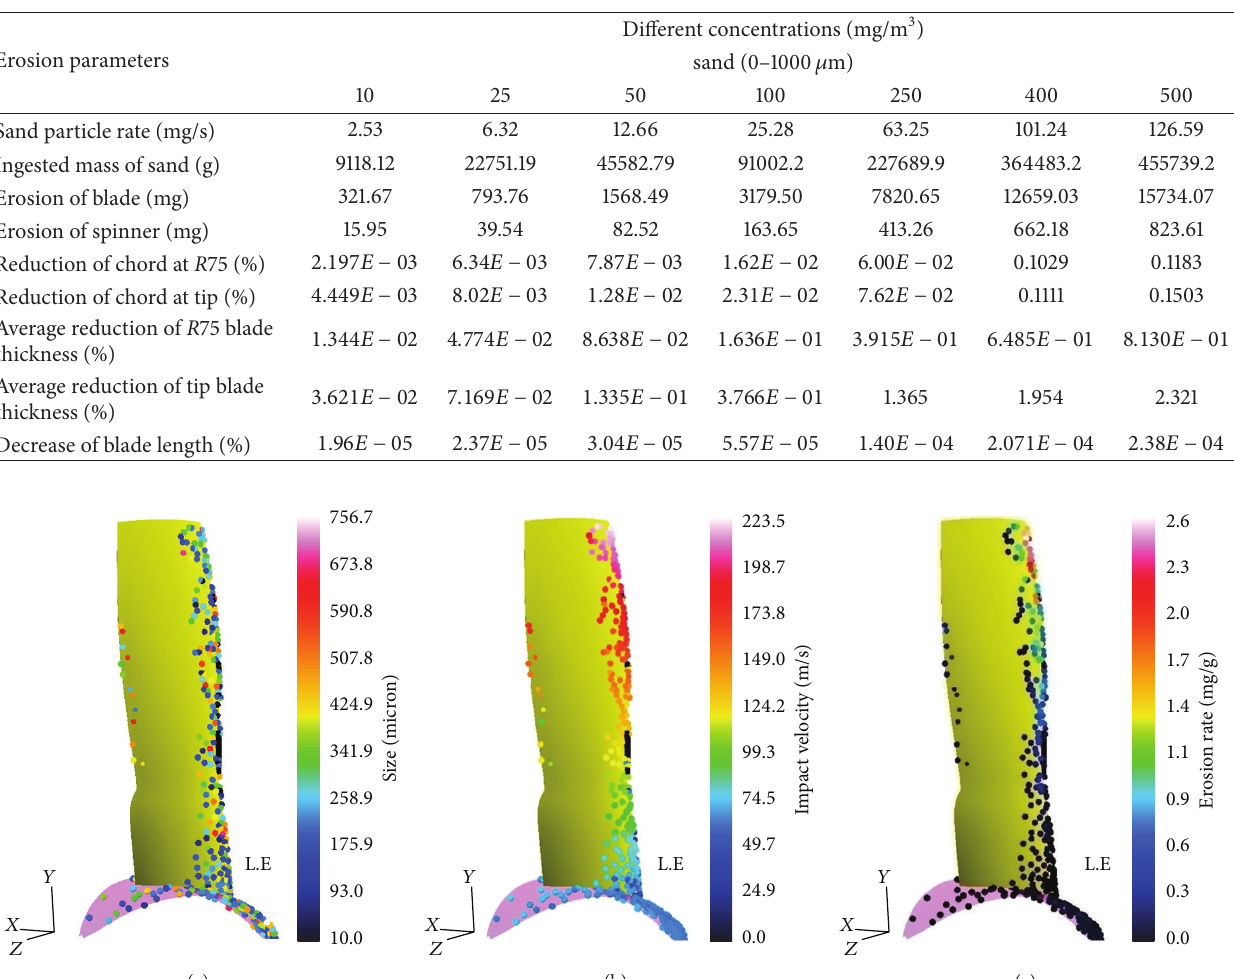
Table 1: Erosion parameters and geometry deterioration of one blade after one hour.